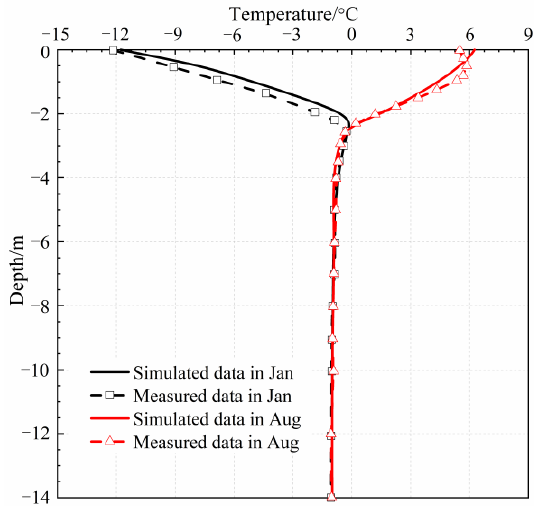
Figure 8. Comparisons between the measured and simulated soil temperatures in January and Au- gust.